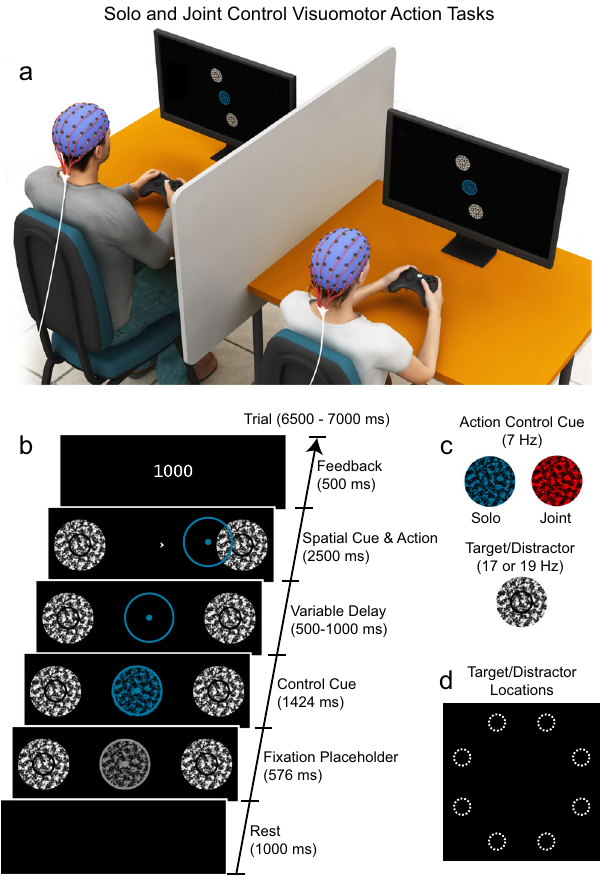
Fig. 1 Solo and joint control visuomotor action tasks with multi-modal recording ( n = 20 pairs). a Co-actors viewed their own display and used video game controllers to move the cursor to the spatially cued peripheral target, while ignoring a distractor positioned at 180° in the opposite hemi fi eld. The artwork was provided by our colleague Dr David Lloyd. b Example trial sequence shown for a segment of the display (enlarged and rotated here for clarity). Participants guided the coloured cursor (a dot and surrounding annulus) to the spatially cued target location (black annulus within the circular textured patch). The position of the cued target within the peripheral array was indicated by a small, central arrowhead (in white), which served as the action onset cue. The green- or red-coloured action control cue and cursor indicated solo or joint control. Note that the green cursor and control cue is depicted as blue in this and subsequent fi gures for the bene fi t of colour-blind readers. Numeric feedback for correct responses re fl ected reaction time (RT) plus movement time (MT). If participants performed the task incorrectly, feedback indicated that the action was “ too fast ” , “ too slow ” or had “ missed the target ” (i.e., the cursor ’ s central dot had not entered and remained within the target annulus, indicated in black). c Frequency-tagged visual stimuli. The action control cue and target and distractor stimuli fl ickered at distinct frequencies, thereby evoking frequency-de fi ned evoked neural oscillations, allowing the measurement of selective attention prior to and during task performance. d All possible target/distractor positions within the display. On each trial, only one target and one distractor were presented (with 180° separation between